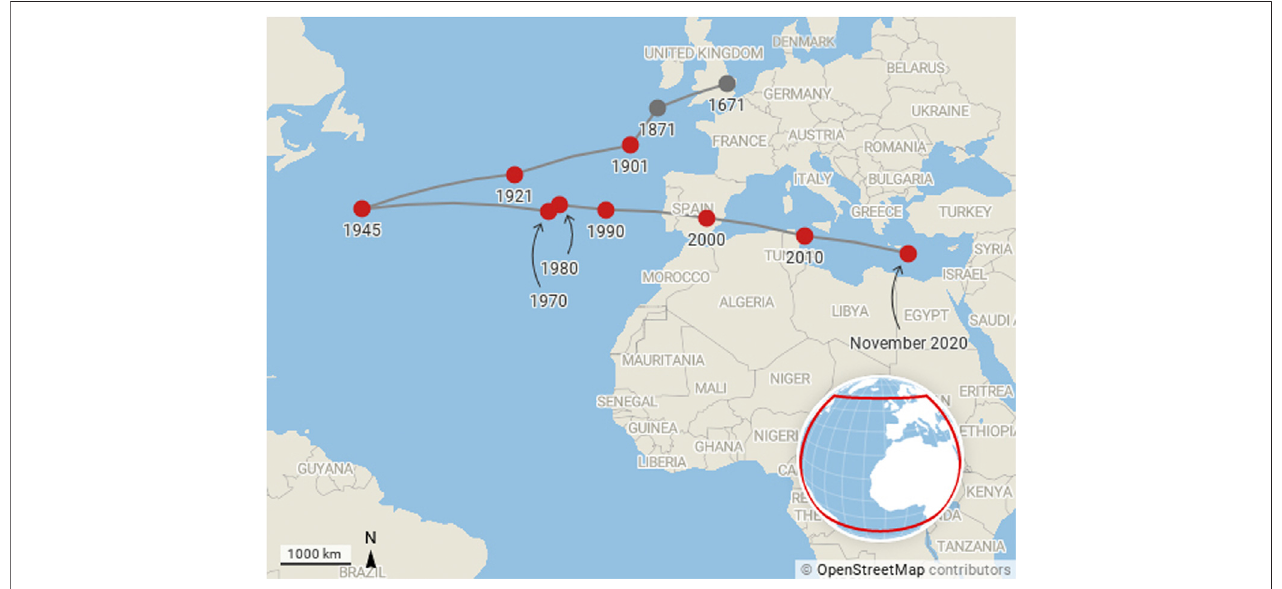
FIGURE 2 | Motion of the centre of mass of research production from 1671 to present day. The centre of mass calculation is unweighted by citations or other measures and is based solely on the outputs of papers by institutions that appear in the GRID database.